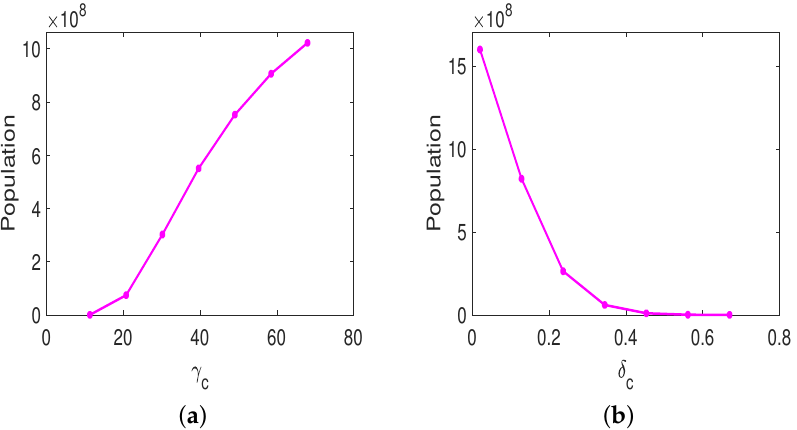
Figure 7. Susceptible tumor size with combination therapy. The tumor size is plotted against ( a ) γ c , the decay rate of tumor-suppressing cytokines; ( b ) δ c , the tumor killing rate by